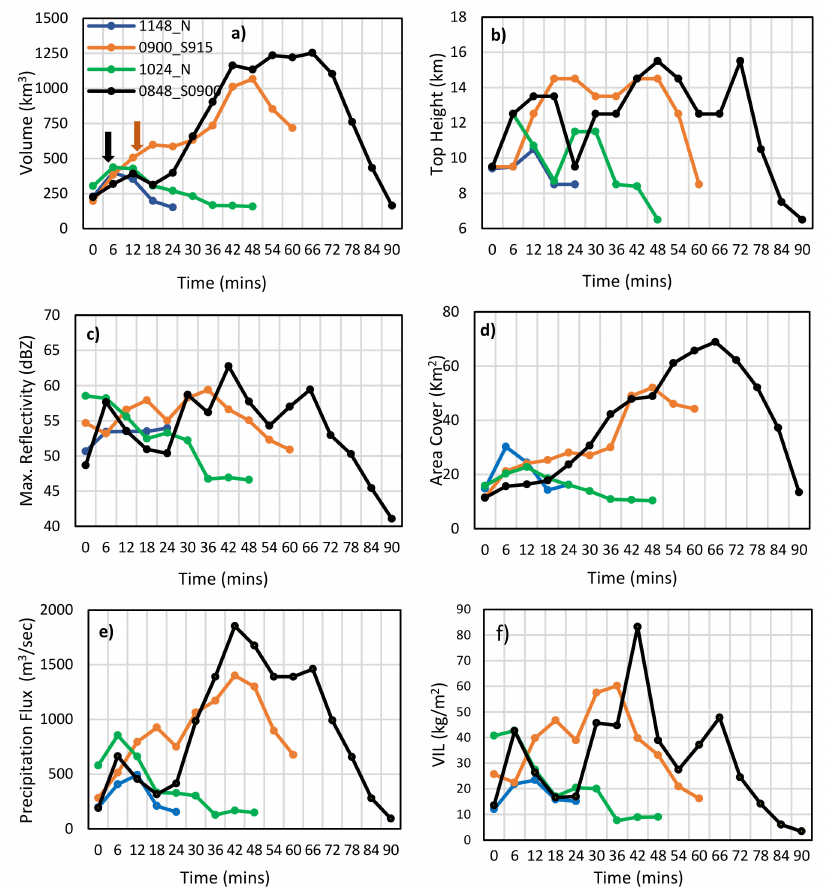
Figure 6. Temporal evolutions of ( a ) echo volume ( b ) echo top height, ( c ) maximum reflectivity ( d ) echo area cover ( e ) precipitation flux and ( f ) vertically integrated liquid water derived from the radar network for 24 October 2018 storms as a function of time (mins). The 0848_S0900 (black) curve denotes a storm first detected at 08:48 UTC and seeded at 09:00 UTC, and the 0900_S915 (orange) curve denotes a storm first detected at 09:00 UTC and seeded at 09:15 UTC. The 1148_N (blue) 1024_N (green) curves denote storms first detected at 11:48 UTC and 10:24 UTC, respectively, and not seeded. The arrows in panel ( a ) depict the onset of seeding for each seeded storm with the matching